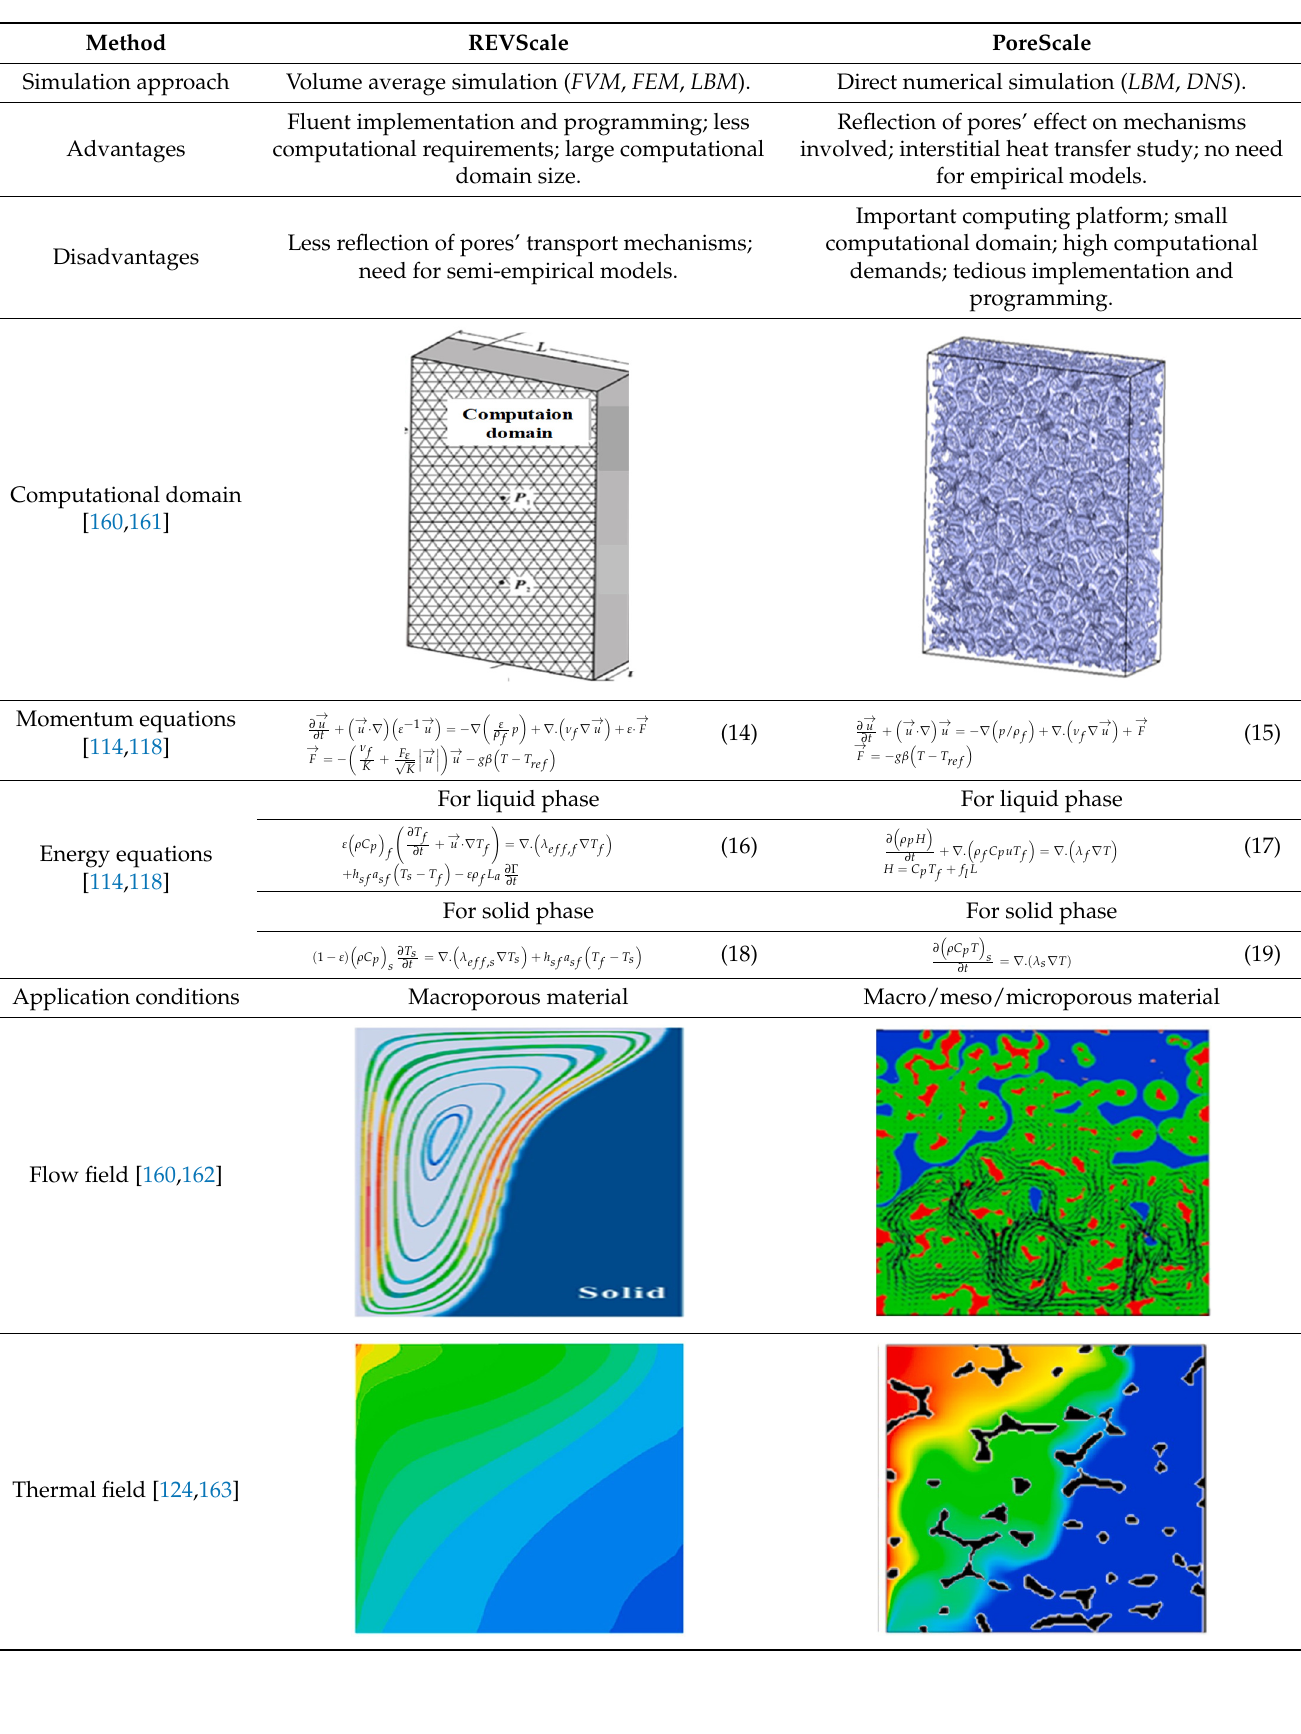
Table 9. REV scale vs. pore scale (principle, advantage/disadvantage, geometry, governing equations).